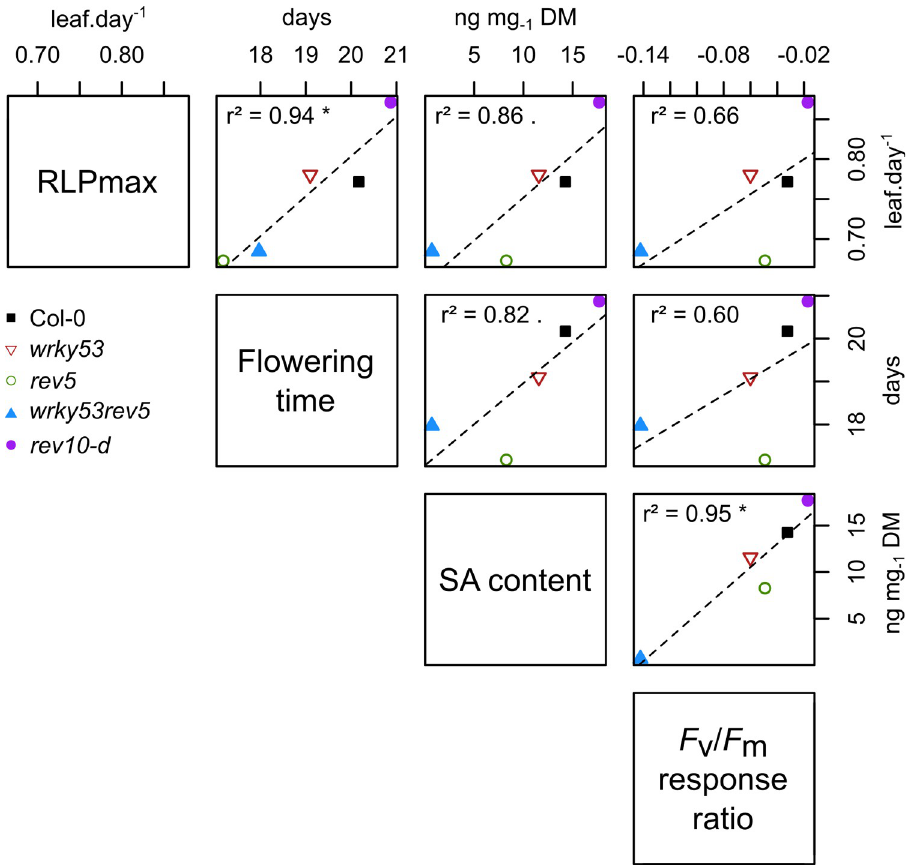
Fig 6. Correlations amongst key traits of plant development and immunity. Pearson correlation coefficients within the different genotypes of key traits of plant development and immunity. RLP max is the maximum rate of leaf production calculated as the slope estimated by fitting a linear curve for each plant over time. Salicylic acid (SA) and F v / F m response ratio were measured at 15 days after flowering and 6 days after inoculation, respectively. ( � : P � 0.05,.: P �